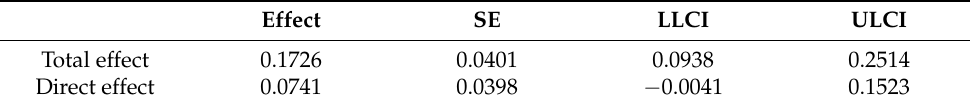
Table 3. Total and direct effects and the confidential